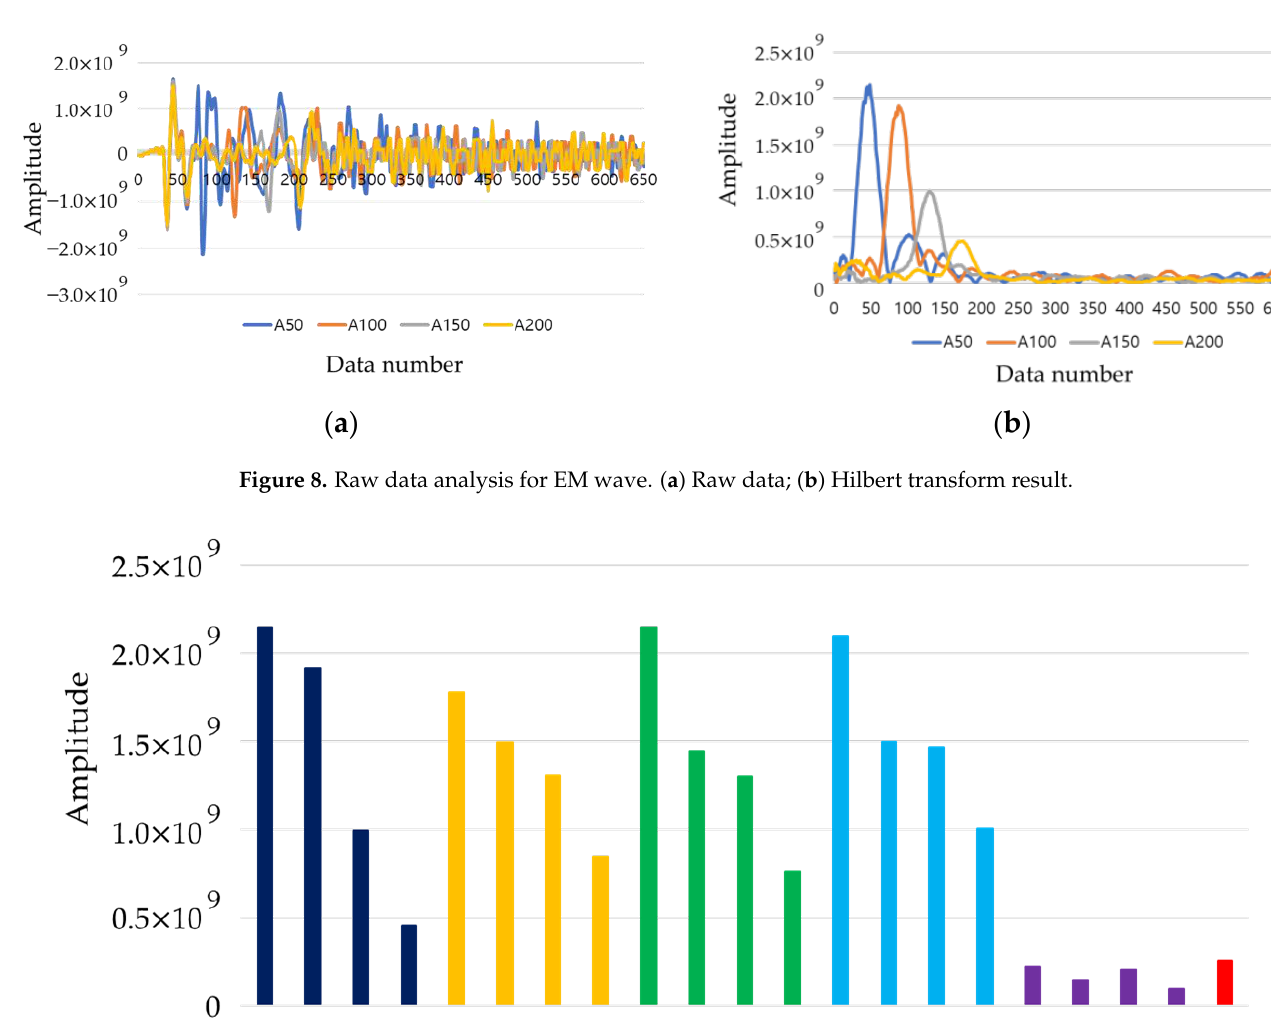
( d ) ( e) Figure 7. Test results by RC radar. Slabs: ( a ) A; ( b ) B; ( c ) C; ( d ) D; ( e ) E (dimensions in mm). As shown in Figure 7, when commercial equipment is used, a quantitative analysis is difficult because only a rough evaluation on the extracted B scan is possible. Therefore, the analysis was conducted using raw data collected from RC radar. Figure 8a shows the